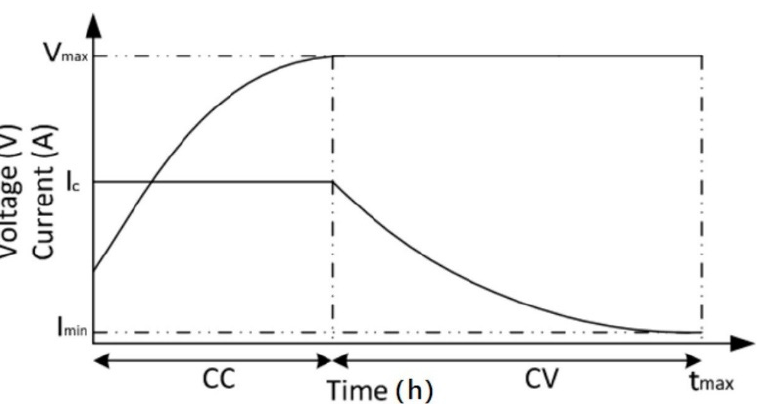
Figure 4. Charging stages of Li-ion charging CC/CV.